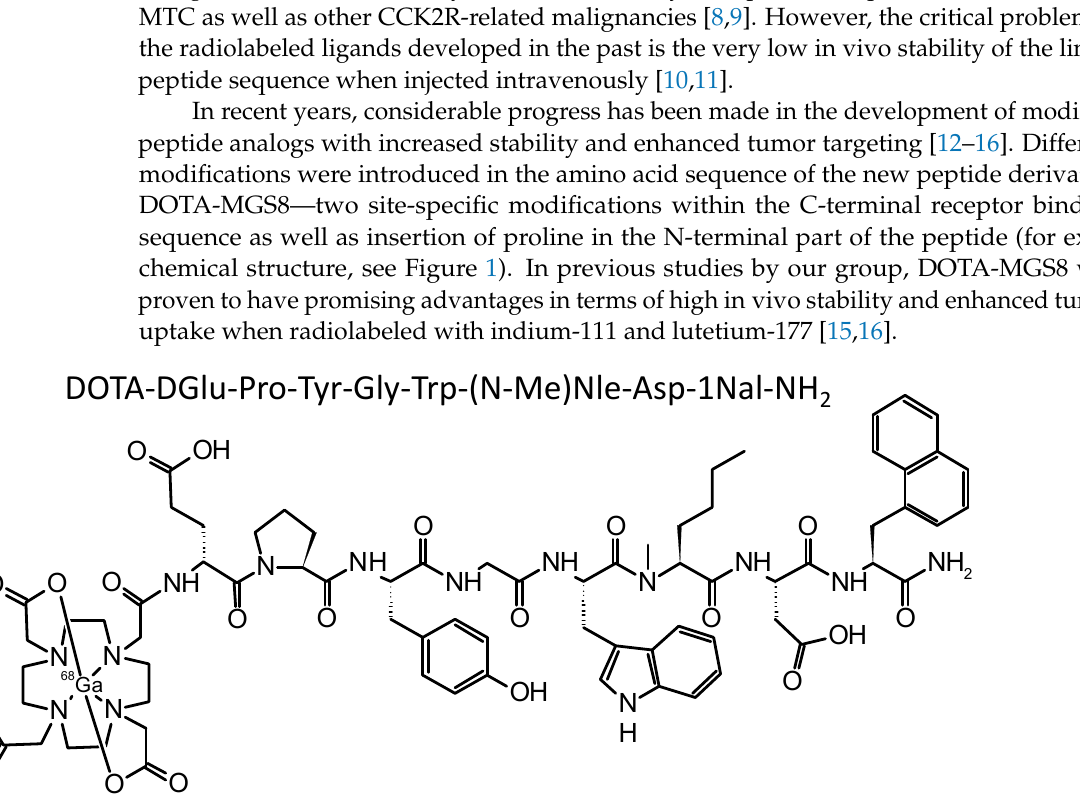
Figure 1. Amino acid sequence of DOTA-MGS8 and chemical structure of [ 68 Ga]Ga-DOTA-MGS8.